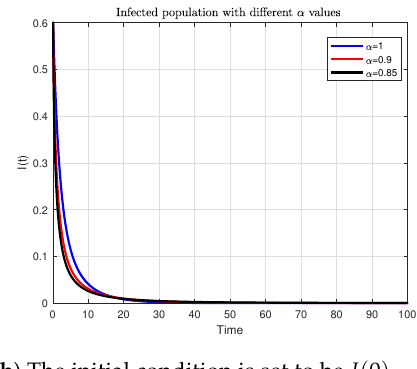
( b ) The initial condition is set to be I ( 0 ) = 0.6 for α = 0.85,0.9,1. The susceptible population for α = 0.85,0.9,1. The infected population converges asymptotically to S 0 = 1.5 = Ψ / µ . converges asymptotically to I 0 = 0. Figure 1. Numerical simulations of the model (5) with different α values and the Holling type III function response. For the set of parameters Ψ = 0.75, µ = 0.5, η = 0.1, β = 0.3, ρ = 0.15, δ = 0.05 and τ = 0.1 we have R 0 = 1.1538 > 1. Thus, the endemic steady-state solution is asymptotically stable.